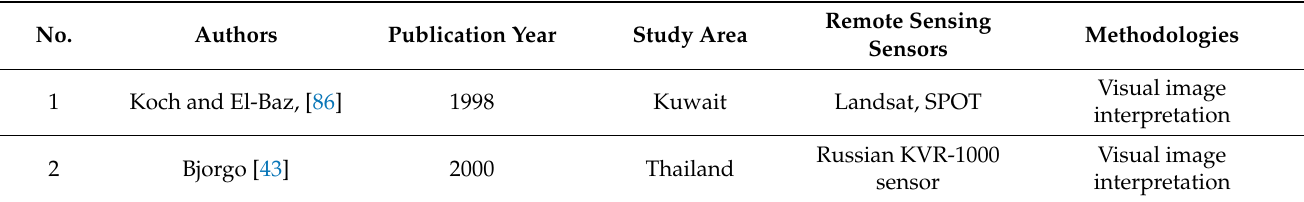
Table 1. Major case studies associated with applications of remote sensing data in peace and security.